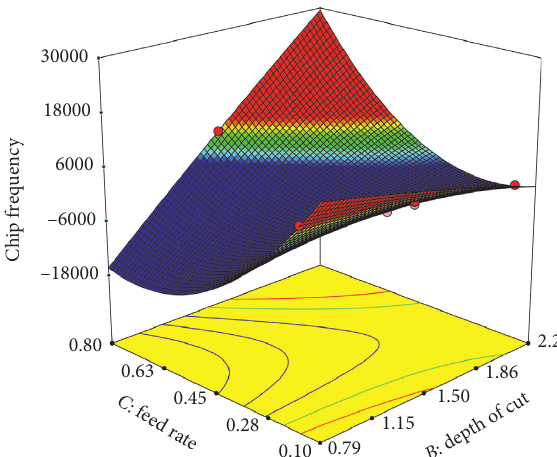
Figure 16: Surface plot of chip frequency based on the combi- nation of cutting speed and feed rate.